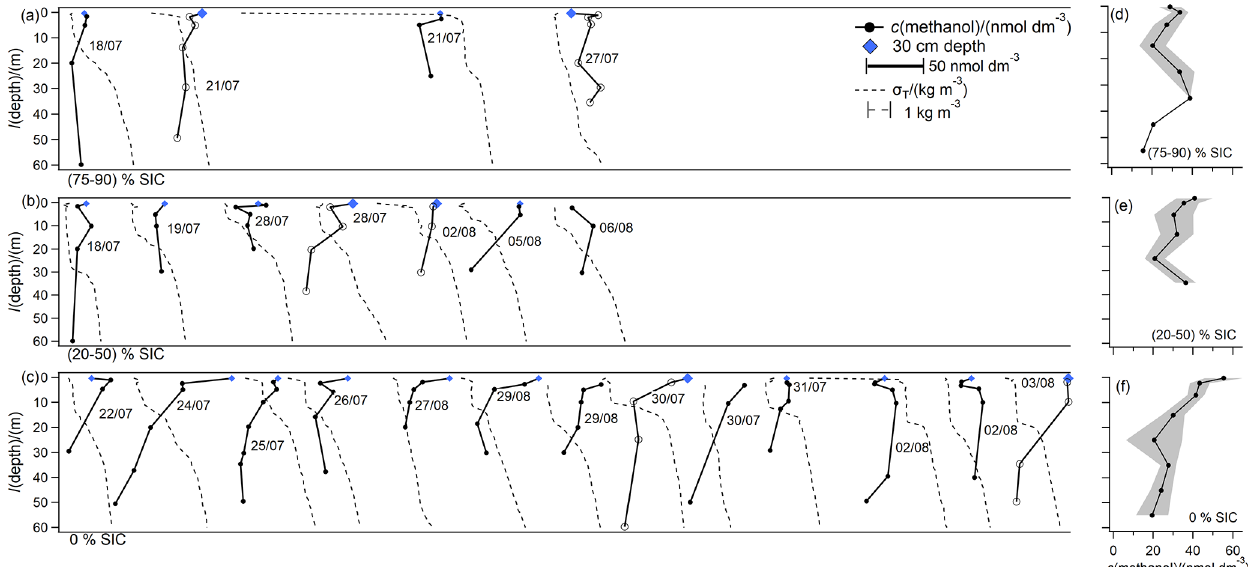
Figure 2. Overview plot displaying the shape of all methanol and density ( σ T ) depth profiles, grouped by SIC and staggered along the x axis for ease of viewing. Panel labels indicate the SIC bin. The scale bars for methanol and density in (a) also apply to (b) and (c) . Profiles with hollow markers are highlighted in Fig. 7. Sampling dates are indicated to locate stations using Fig. 1. Panels (d) to (f) indicate absolute concentrations of mean vertical profiles grouped according to ice cover and binned by depth horizons. The shaded area indicates standard error for each depth